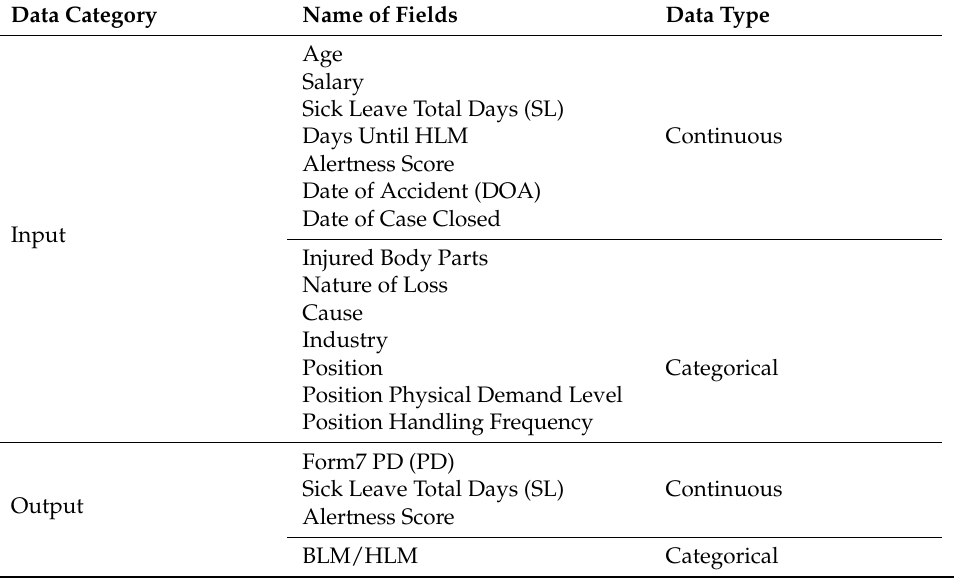
Table 2. Input and output data.